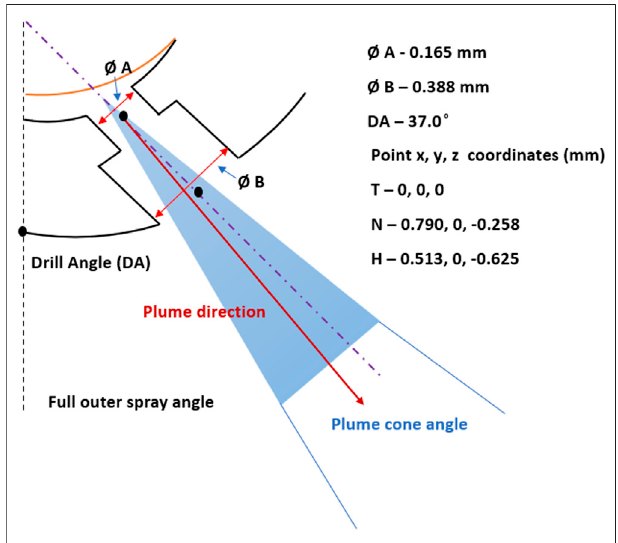
FIGURE 1 | Spray G injector nominal geometry details and